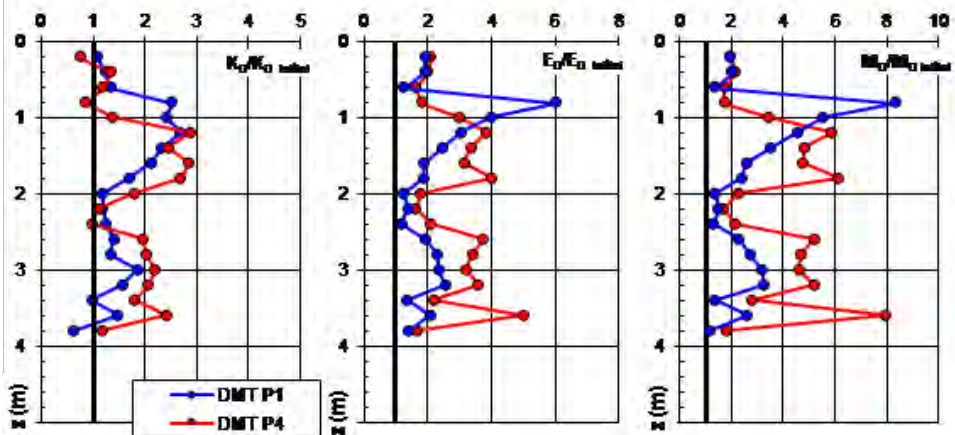
Figure 17. Results of SDMT after RIC compared to those before RIC.